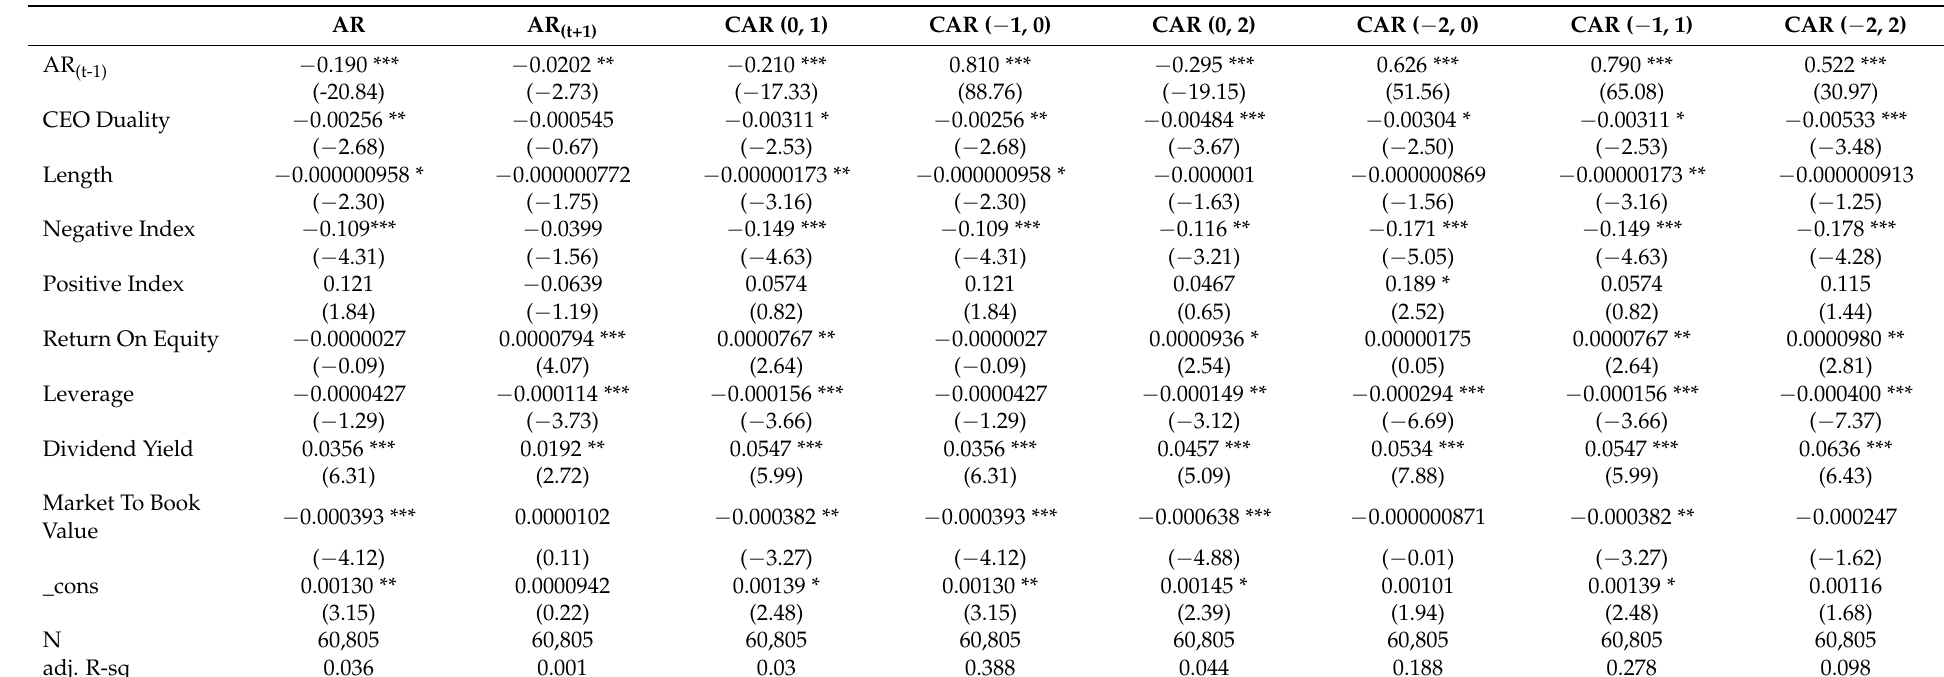
Table 8. CEO duality, sentiment and stock market